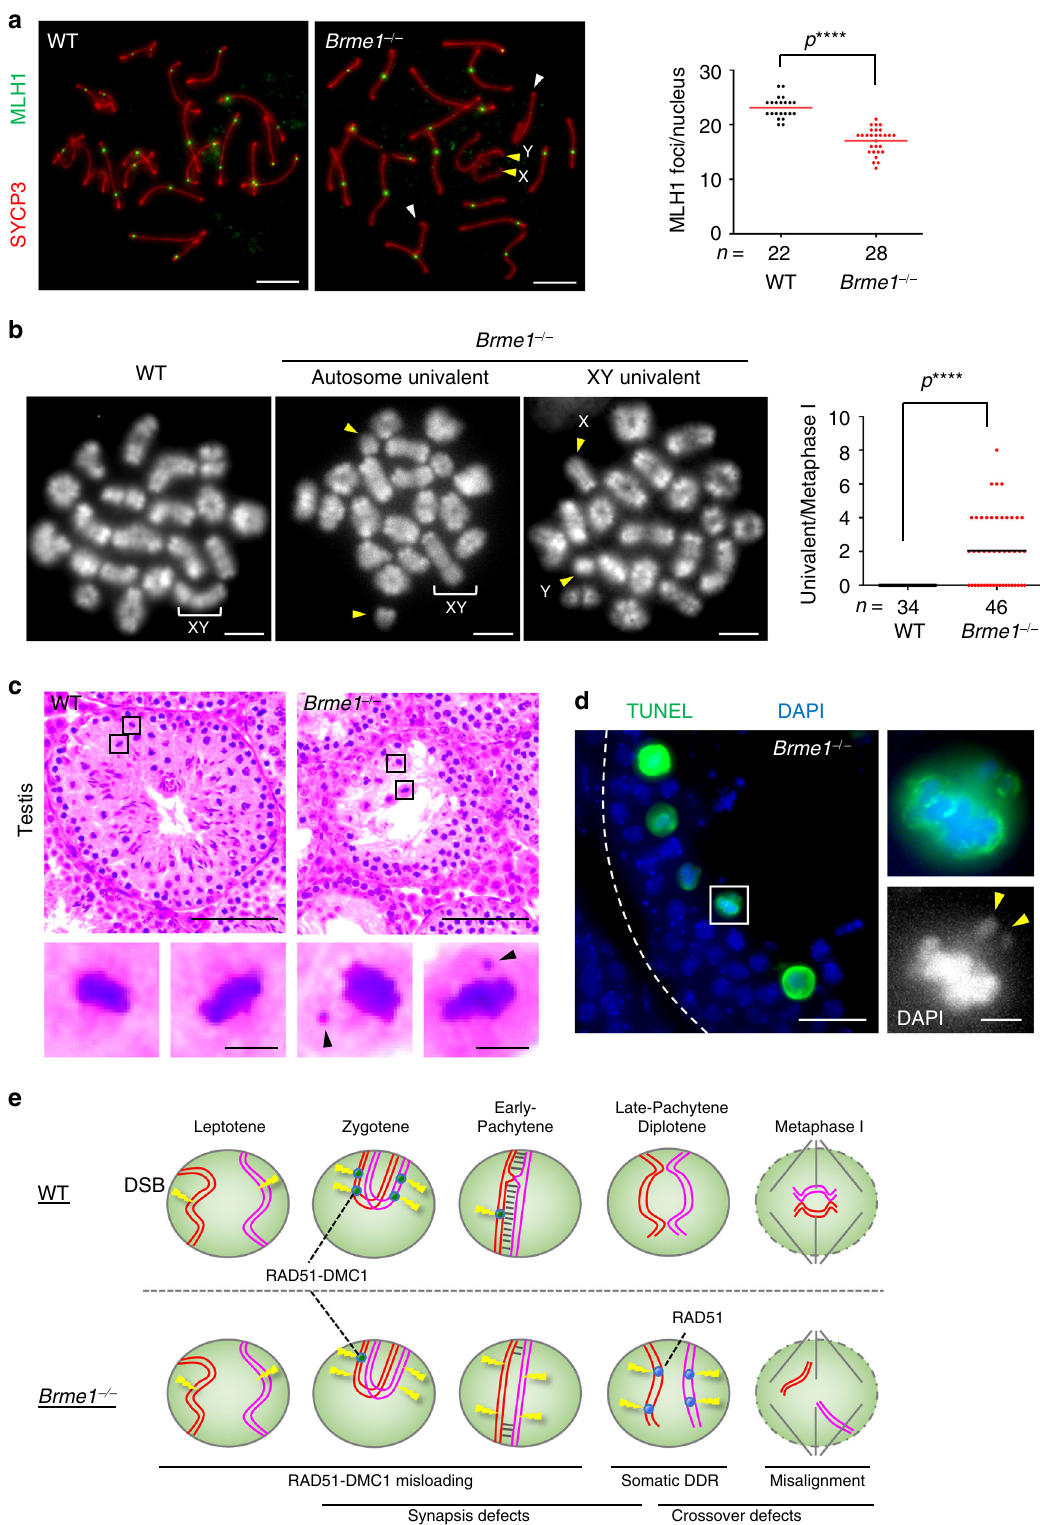
resuspending in a 1:1 mixture of PBS and hypotonic buffer (30 m M Tris (pH 7.5), 17 m M trisodium citrate, 5m M EDTA, 2.5m M DTT, 0.5m M PMSF, and 50 m M sucrose). After 10 min, the sample was centrifuged and the supernatant was aspirated. The pellet was resuspended in a 1:2 mixture of PBS and 100m M sucrose. A total of 20 μ l of fi xation buffer (1% paraformaldehyde, 0.15% Triton X-100, and 1 m M Sodium Borate (pH 9.2 adjusted by NaOH)) was applied to a glass slide, and 3 μ l of the cell suspension was added to the drop, allowed to fi x for 1 h at